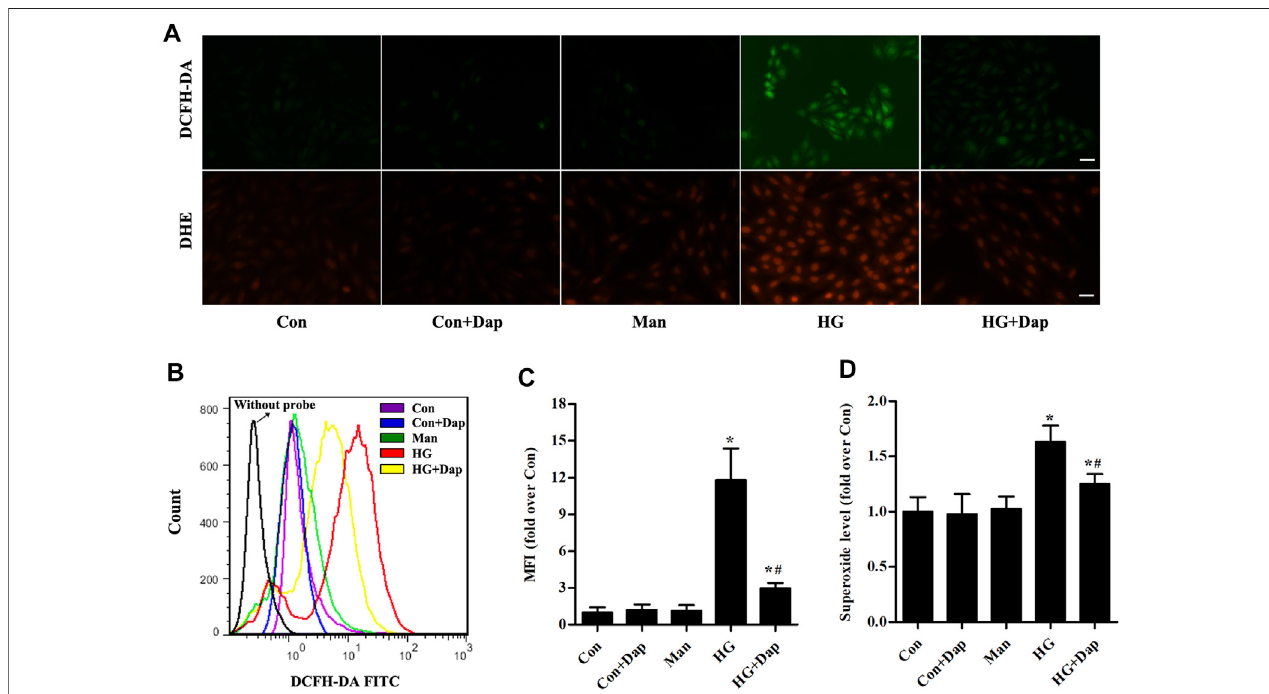
FIGURE 5| Effects of DAP on high glucose-induced oxidative stress in H9C2 cells. The treatment protocol ofH9C2 cells is the same asthat in Figure 4 (A) Upper panel, thegenerationofhydrogen peroxidewasassessed usingaDCFH-DA probe. Thegreensignal ofDCF wascaptured bya fl uorescence microscope aspresented. Lowerpanel,thegenerationofsuperoxideanionwasassessedusingaDHEprobe.Theredsignalofethidiumwascapturedbya fl uorescencemicroscopeaspresented. Scale bar (cid:1) 100 µm (B) Representative pictures of ROS (hydrogen peroxide) generation in H9C2 cells measured by fl ow cytometry using the DCFH-DA probe (C) Histogram represents quantitative analysisof mean fl uorescence intensity (MFI) ofDCF in H9C2 cells (D) The levels ofsuperoxide in H9C2 cells were assessed. n (cid:1) 3 – 4. Data are expressed as the mean ± SD. * p < 0.05 vs. Con; # p < 0.05 vs. HG.